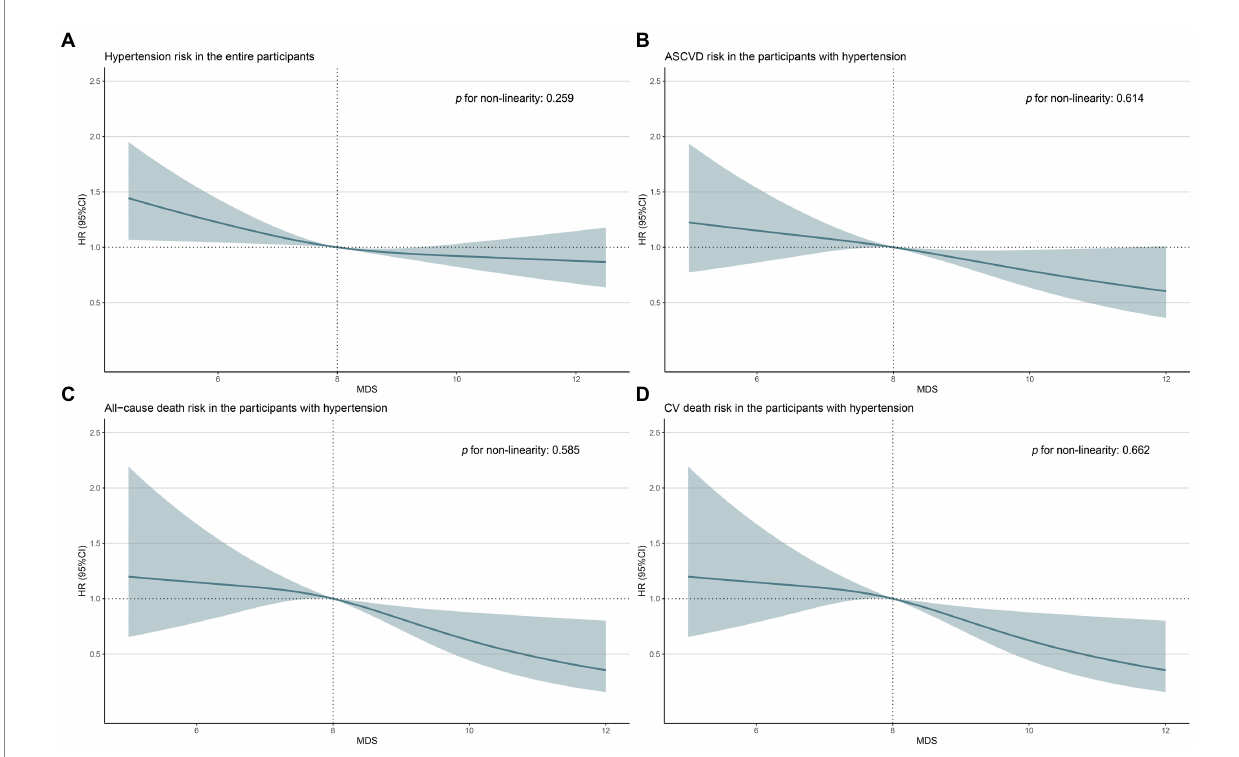
FIGURE 3 Restricted cubic spline models for the associations of MDS with the risk of hypertension in the entire participants (A) , and the risk of ASCVD (B) , all- cause death (C) , and CV death (D) in hypertensive patients. ASCVD, atherosclerotic cardiovascular disease; CV, cardiovascular; MIND diet, Mediterranean-DASH Diet Intervention for Neurodegenerative Delay diet; MDS, the MIND diet